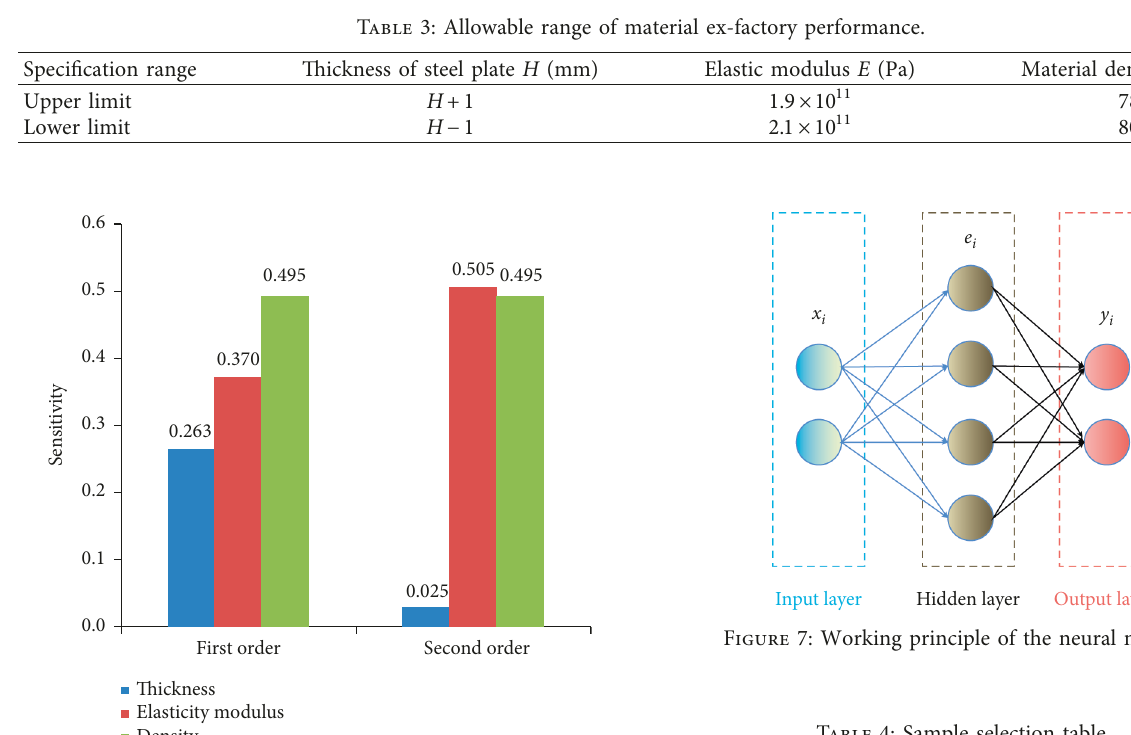
Table 4: Sample selection